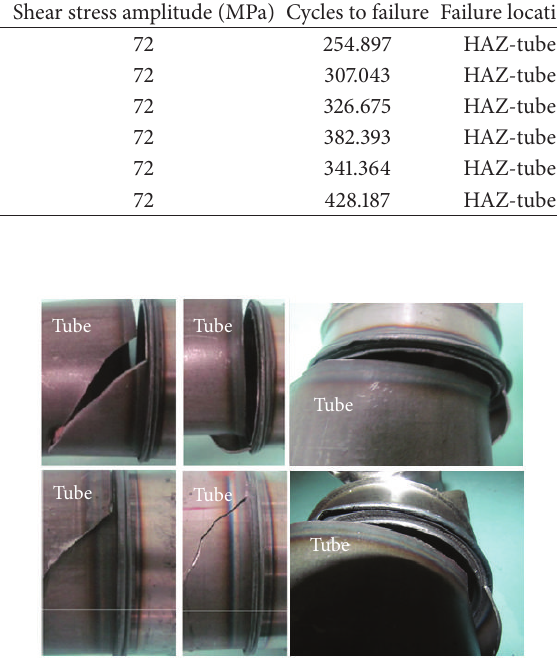
Figure 13: Fatigue failures of welded joints during fully reversed fatigue tests.